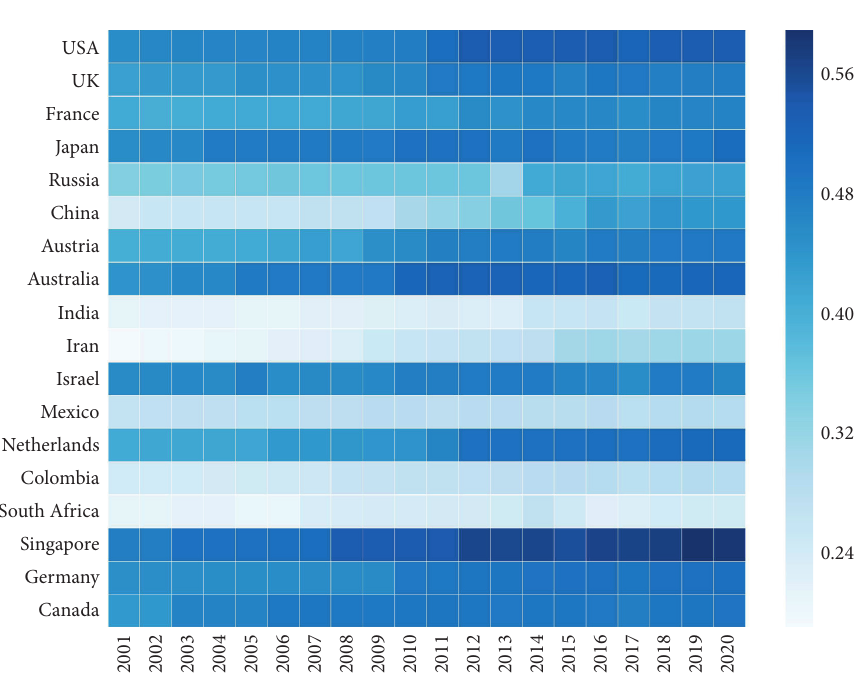
Figure 2: The scores of higher education development in various countries in the past 20 years.